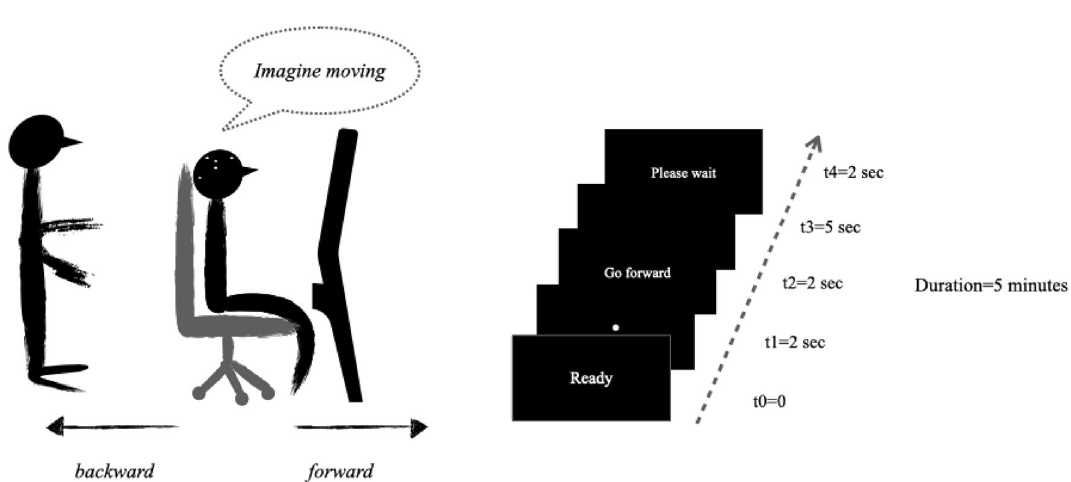
Figure 3. The experimenter instructed the participants to perform the mental imagery of whole-body motion from a first-person perspective: imagine move forward vs backward one at a time. To that end, the experimenter explained the paradigm to the participants step by step (i.e. from t = 0 to t = 4) verbally assisting each participant to respect the chronology and directives of each step (i.e. fix, read, imagine, relax) within the trials (i.e. experimenter-participant training). Each participant was also assisted to perform the task by him/herself as well (i.e. participant training). Participants were equipped with 32-electrode wireless EEG who correctly performed the training phase and clearly confirmed understanding of the task were included in the study. Experimental phase. As previously stated, during the experimental phase each participant was seated on the same chair that s/he used for the mental preparation phase, the baseline and the training phase. Along with the training phase, each participant was adjusted in the front of an LCD screen monitor and instructed to imag- ine his/her own body motion when appropriate (Fig. 4). The experimental paradigm was the same as presented in the training phase. A typical trial run was as follows: the start of each trial was signified by the presence of a short message “ready” in the middle of a black screen. This corresponded to t = 0. Two seconds after, a fixation point appeared in the middle of the screen for 2 s, i.e. t = 1, fixation point. Post the 2 s interval, a visual index, that is, a phrase, indicating either "go forward" or "go backward" appeared for 2 s on the screen. Each phrase (i.e. direction-phrase) constituted the visual cue (i.e. t = 2 ) and, by definition, each corresponded to a whole-body movement direction. It required the participant to perform the corresponding motor imagery task, i.e. “go for- ward” or “go backward”. As such, once the words disappeared from the screen, each participant, facing the black screen, performed a motor imagery task, one at a time, for 5 s, i.e. t = 3, imagery task (yellow colour). At the end of each motor imagery task, each participant was instructed to take a break and relax (i.e. please wait, t = 4 ). The inter-trial interval was around 2 s. Each of the two types of motor imagery tasks was displayed 24 times within each sequence in a randomised order, i.e. 48 trials per participant. In total, for 39 participants, there were 1872